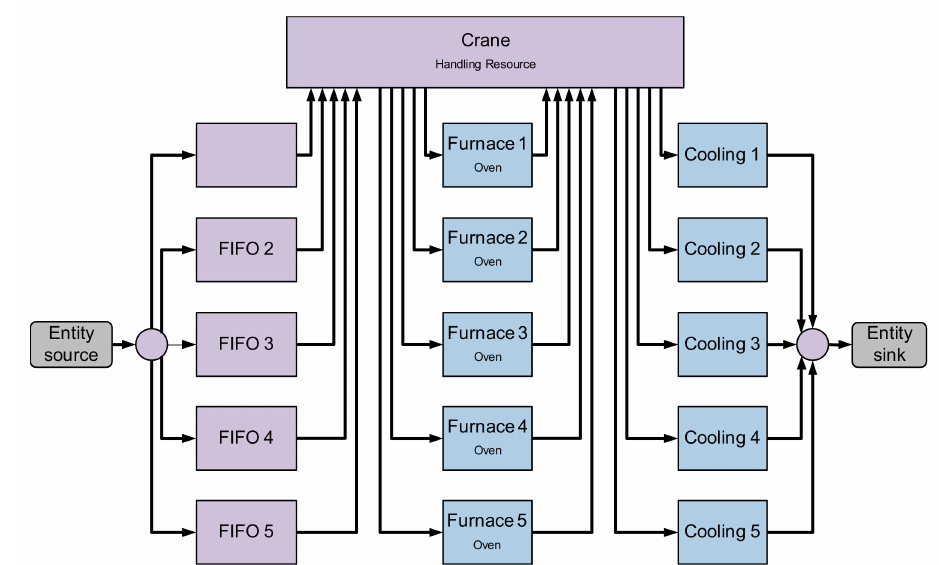
Figure 1. Schematic overview of the production layout comprising five heat treatment furnaces with associated cooling stations and first in–first out (FIFO) loading bu ff ers as well as a crane for loading and